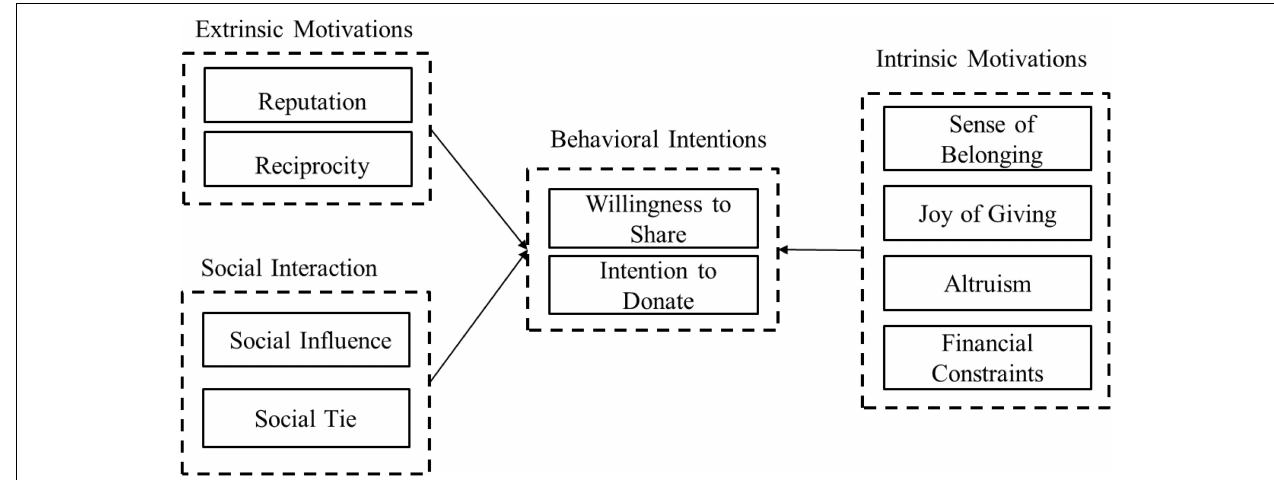
FIGURE 1 | Research